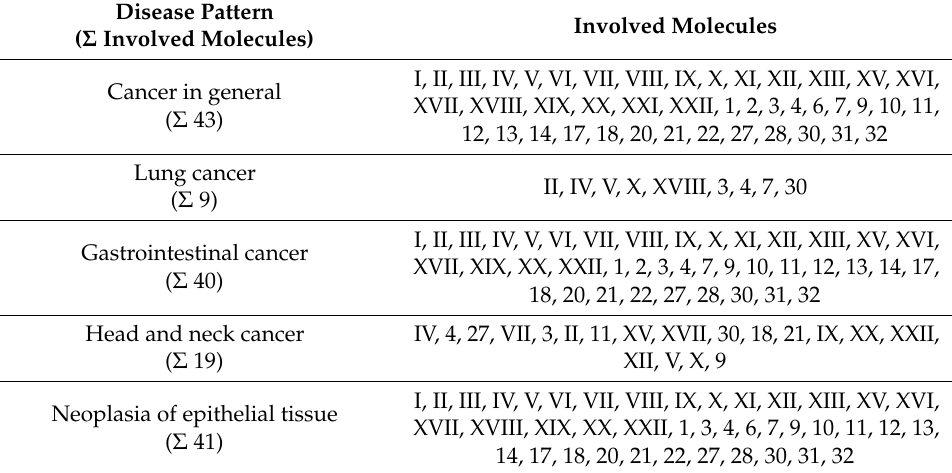
Table 2. Disease patterns predicted by IPA core analysis. Disease patterns with a statistically significant p -value ( p ≤ 0.01) were taken into consideration. The analysis revealed that 40 out of the 54 identified transcripts, specifically regulated by the HBoV infection, are known to contribute to gastrointestinal cancer, whereas only 9 transcripts are associated with lung cancer. Numerals correspond to the ones in Table 1. Roman numerals indicate an upregulation, whereas Arabic numerals represent a